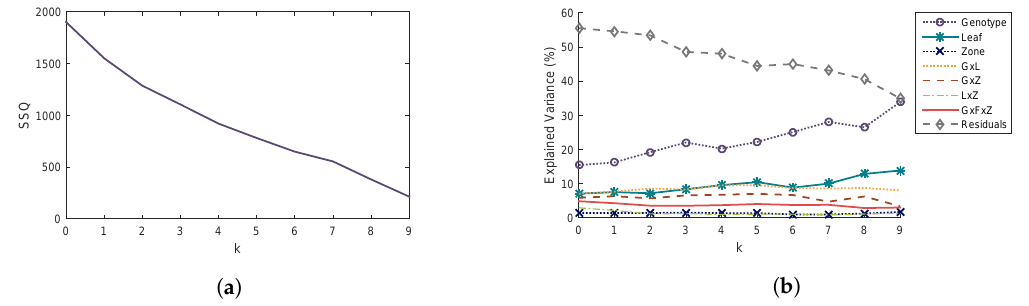
Figure 4. Influence of the number k of components taken into account for the orthogonal projection on ( a ) total variance SSQ of X ⊥ and ( b ) percentages of variance explained for each